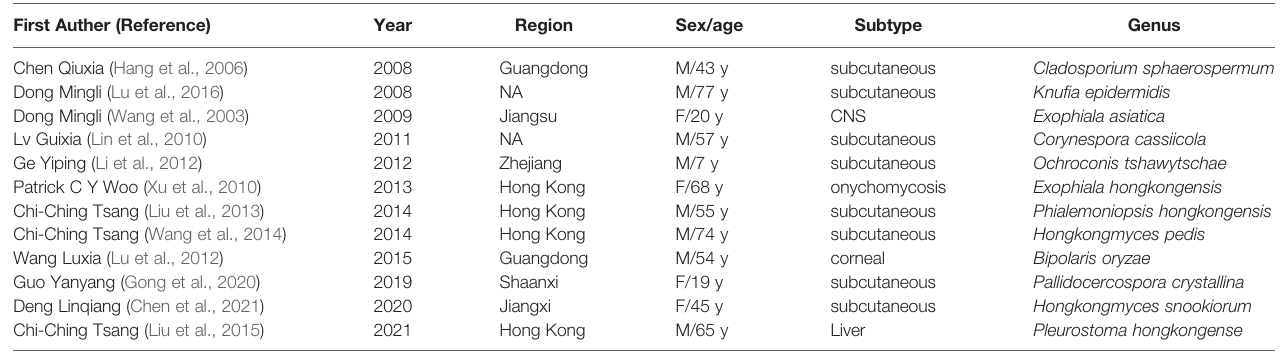
TABLE 5 | Twelve strains fi rst reported to cause phaeohyphomycosis in the